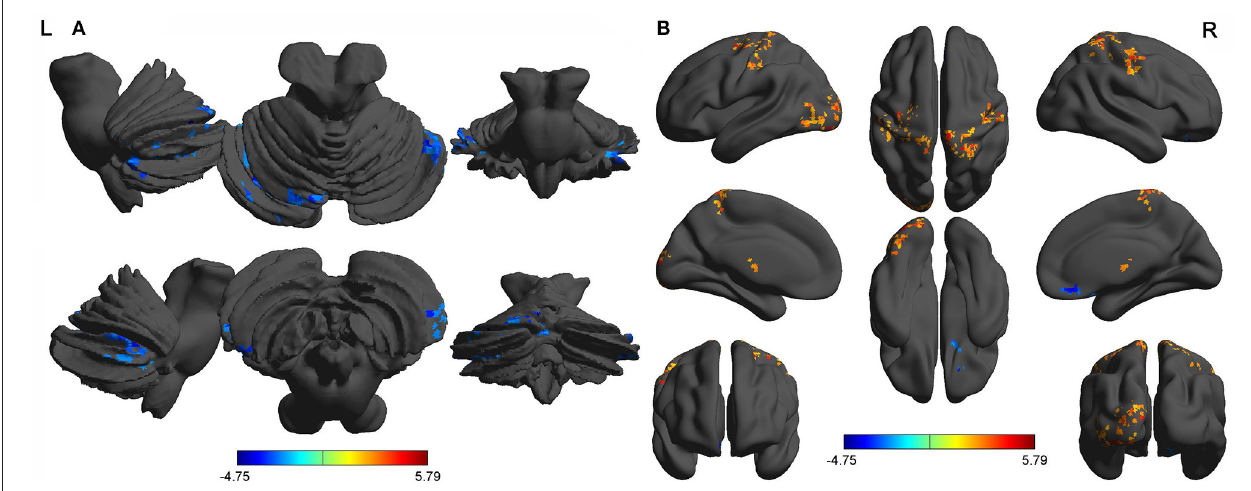
FIGURE 4 | Binarized shortFCD differences between SD and RW. The color in the map represents the differences. The blue signifies decreased binarized shortFCD in brain areas (A) , and the red color signifies increased binarized shortFCD in brain areas (B) . shortFCD, short-range functional connectivity density; SD, Sleep deprivation; RW, Rested wakefulness; L, left; R, right.